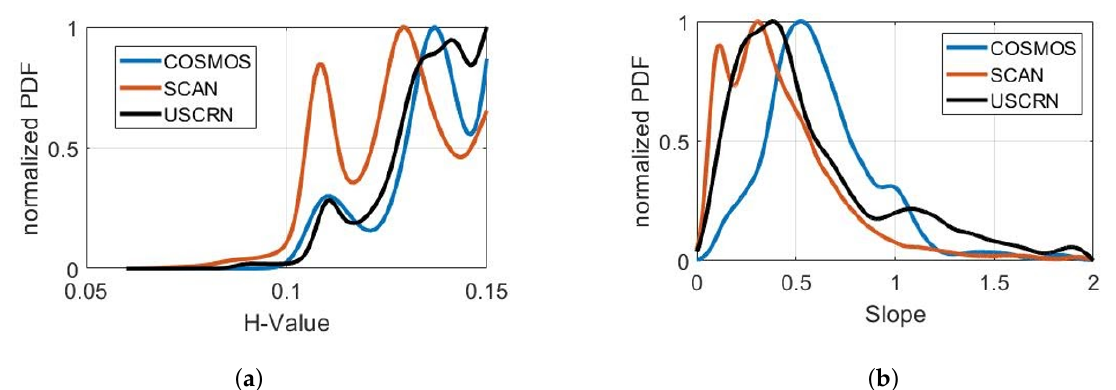
Figure 14. Distribution of ( a ) small scale roughness (H-value) and ( b ) topographic slope input features for each SM